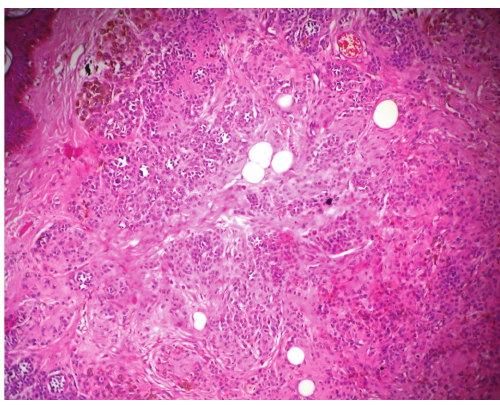
Figure 2: Clusters of nevus cells with melanin pigment (H&E, 40x).